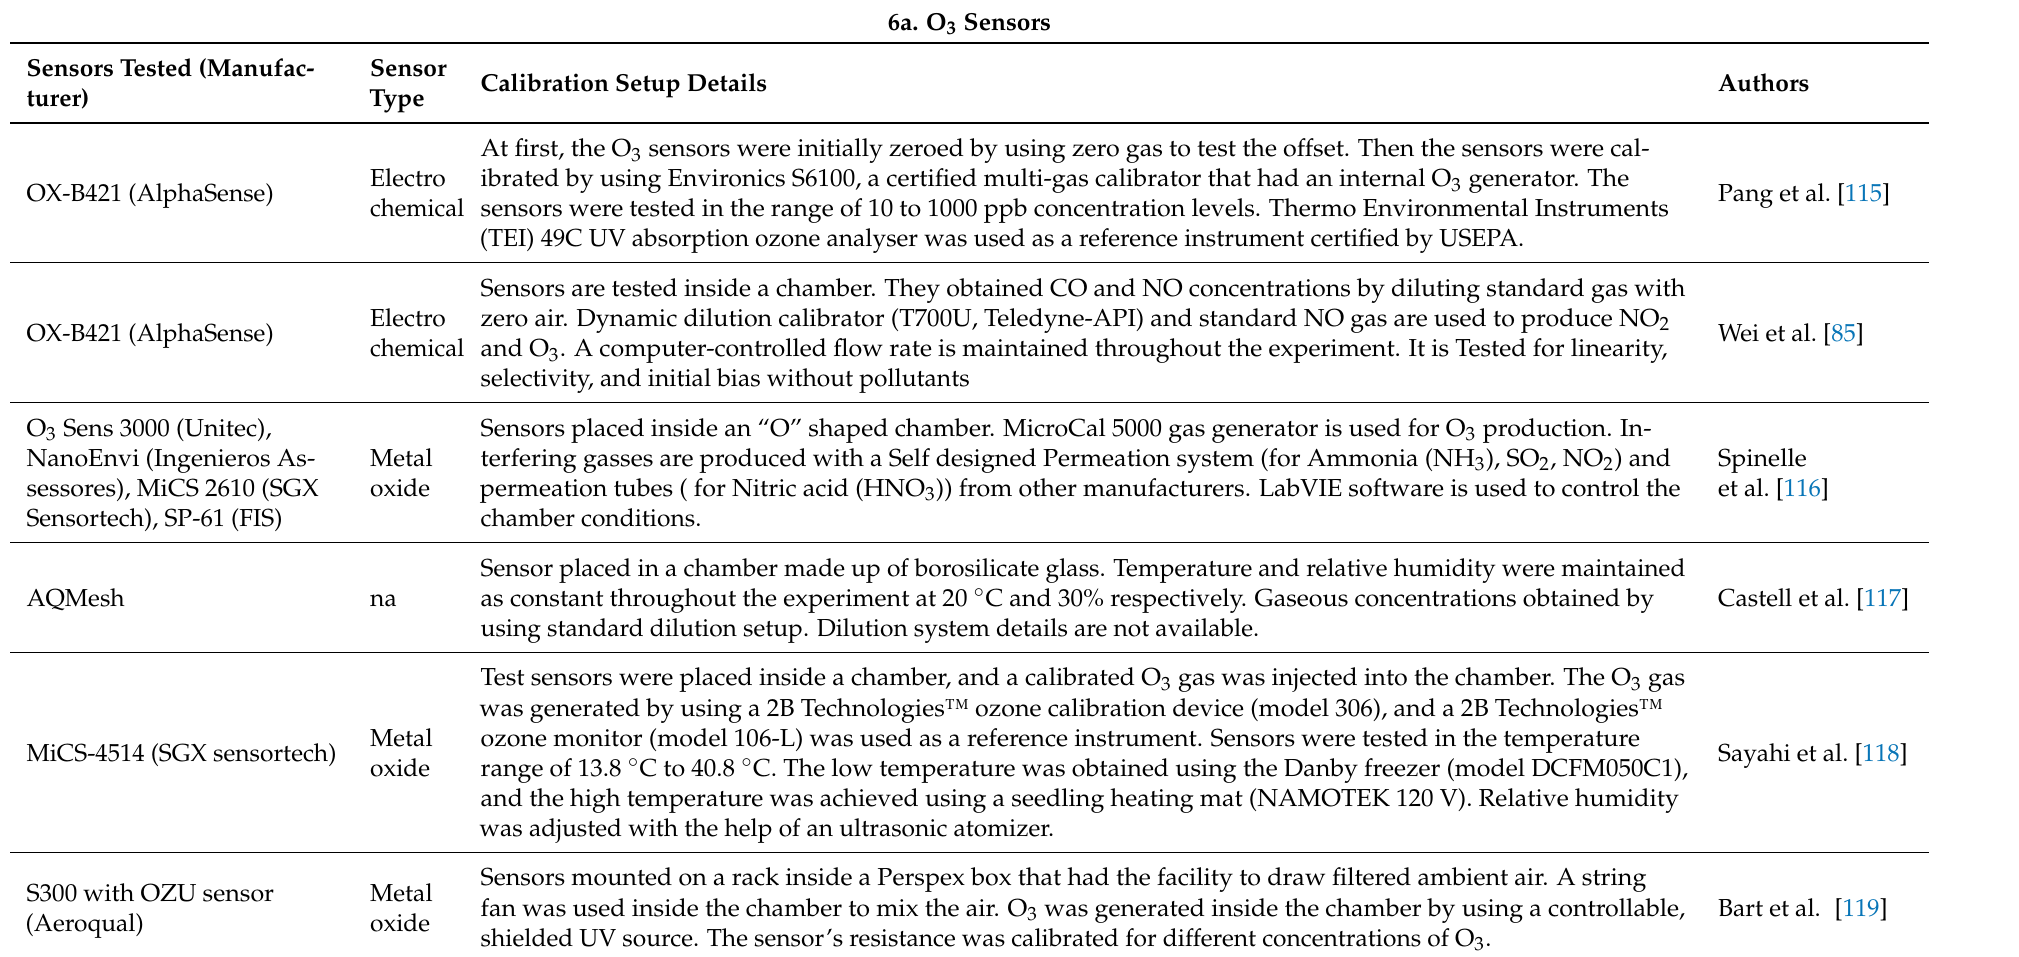
Table 6. Various laboratory calibration setups for gas